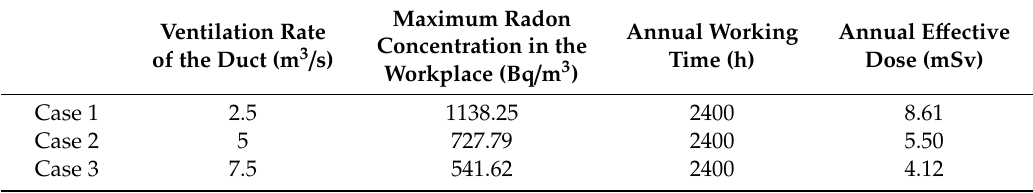
Table 1. Annual e ff ective radon dose to Table 1. Annual effective radon dose to miners.